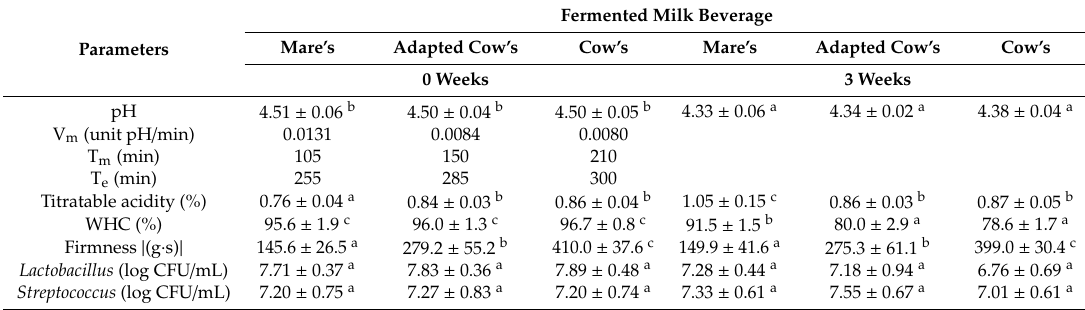
Table 3. Acidity, syneresis, firmness, and lactic acid bacteria of fermented beverages from mare’s milk, cow’s milk adapted to mare’s milk composition, and cow’s